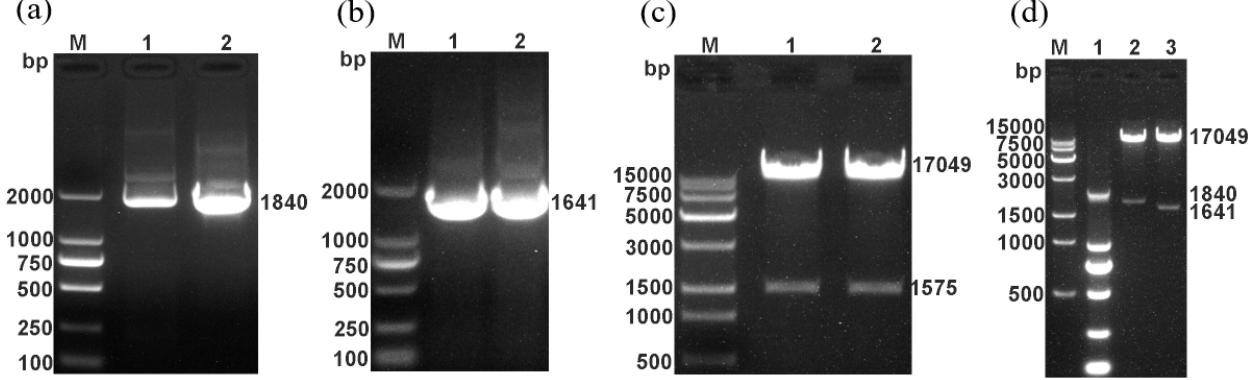
Figure 1. Identification of pD-SRV9-PM-H and pD-SRV9-PM-F via enzyme digestion. ( a ) The con- struction strategy for the recombinant RABV infectious clone. ( b – d ) Identification of pD-SRV9-PM- H and pD-SRV9-PM-F via enzyme digestion. ( a ) M: DNA Marker; 1,2: PPRV-H-PCR; ( b ) 1, 2: PPRV- F-PCR; ( c ) DNA Marker; 1, 2: digestion of pD-SRV9-PM-LASV; ( d ) 2: identification of pD-SRV9-PM- PPRV-H via enzyme digestion; 3: identification of pD-SRV9-PM-PPRV-F via enzyme